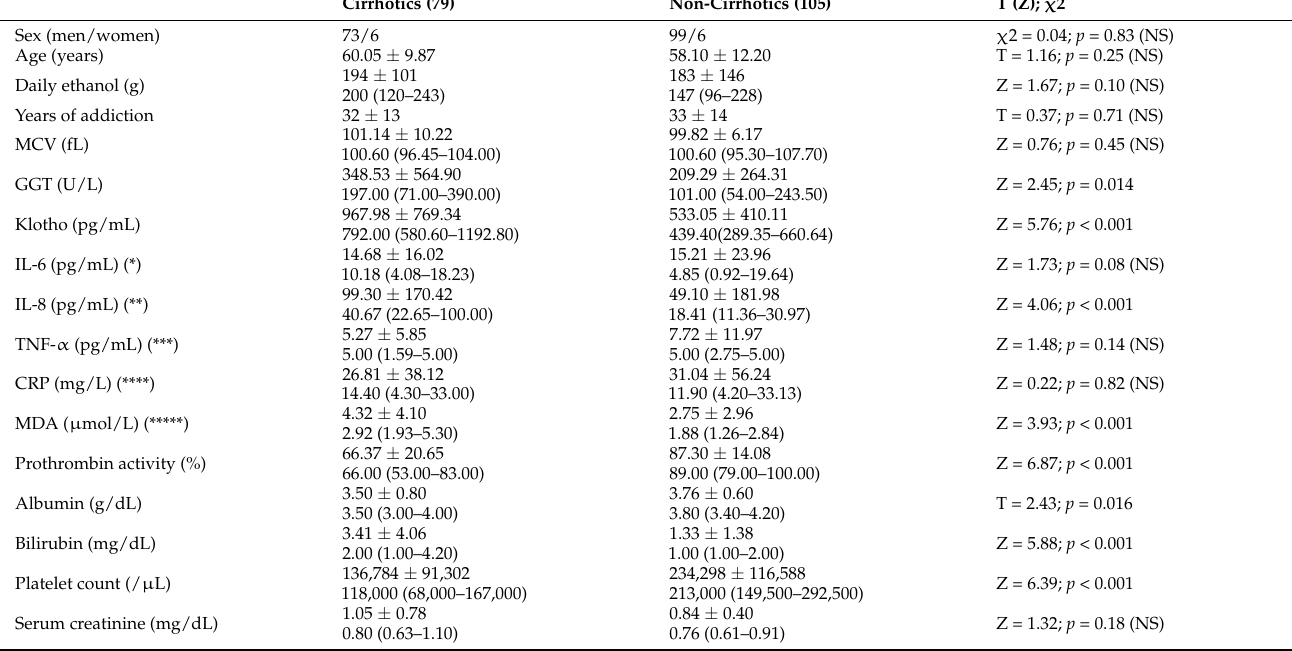
Table 1. Comparison of the variables used in this study among cirrhotics and non-cirrhotics. Cirrhotics (79) Non-Cirrhotics (105) T (Z); χ